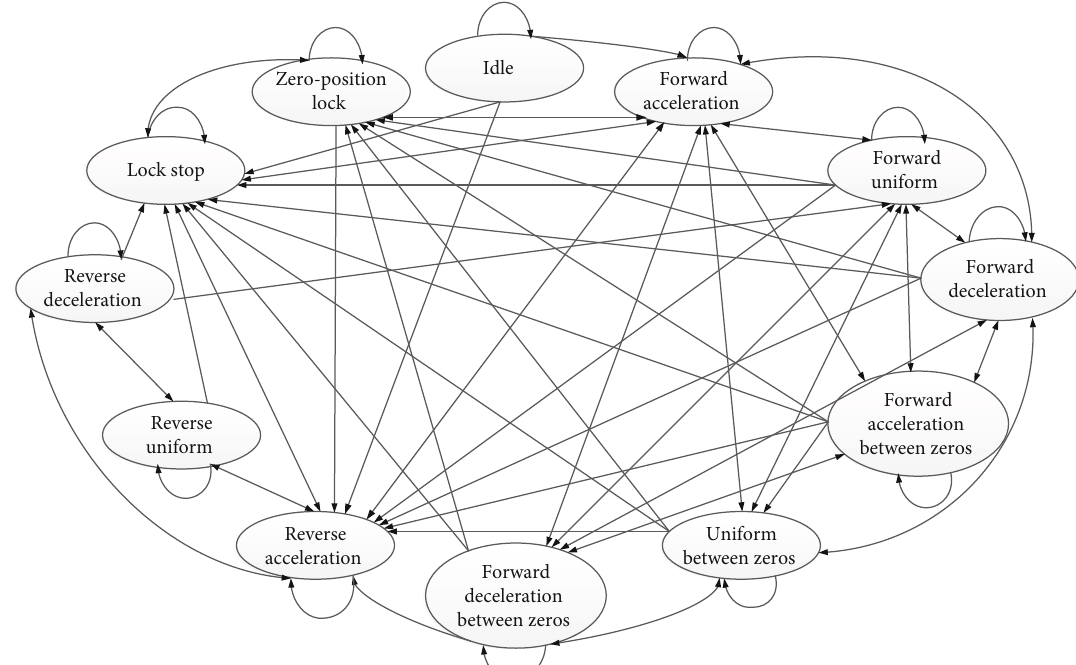
Figure 7: State machine of speed